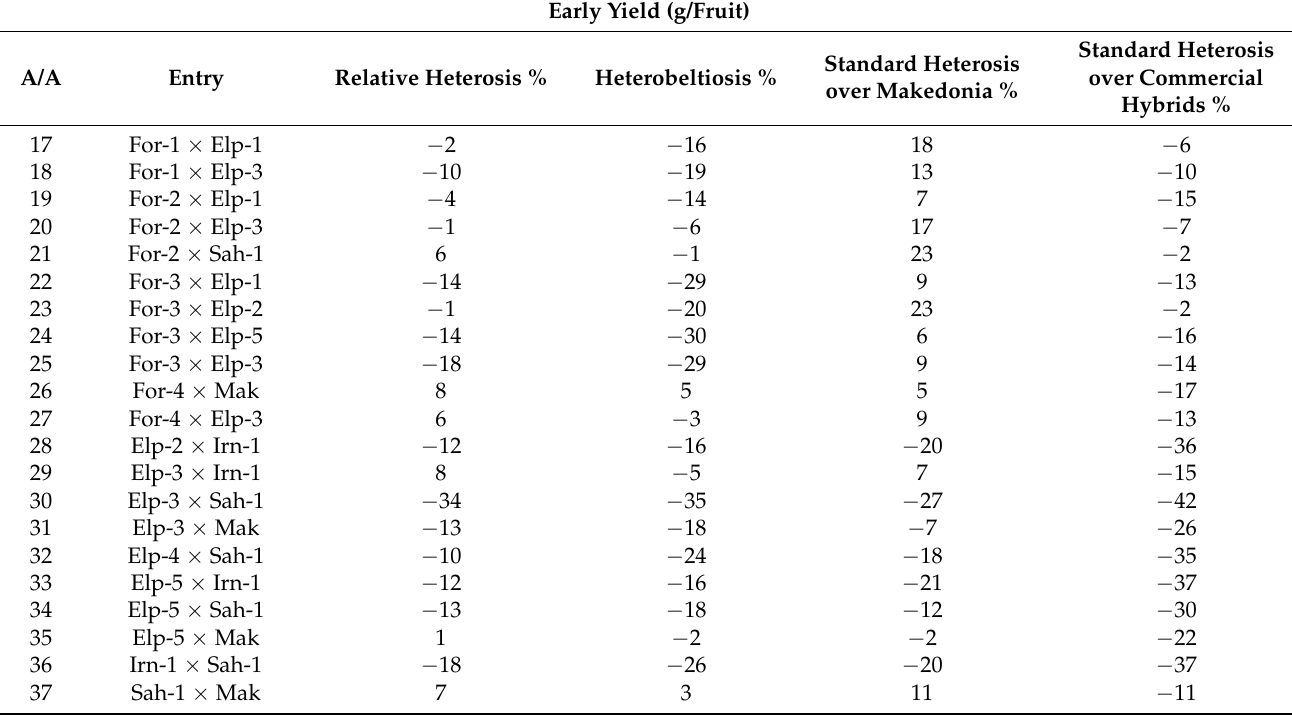
Table 8. Relative heterosis, heterobeltiosis, and standard heterosis of the reconstructed new hybrids for early yield (g/fruit). Early Yield